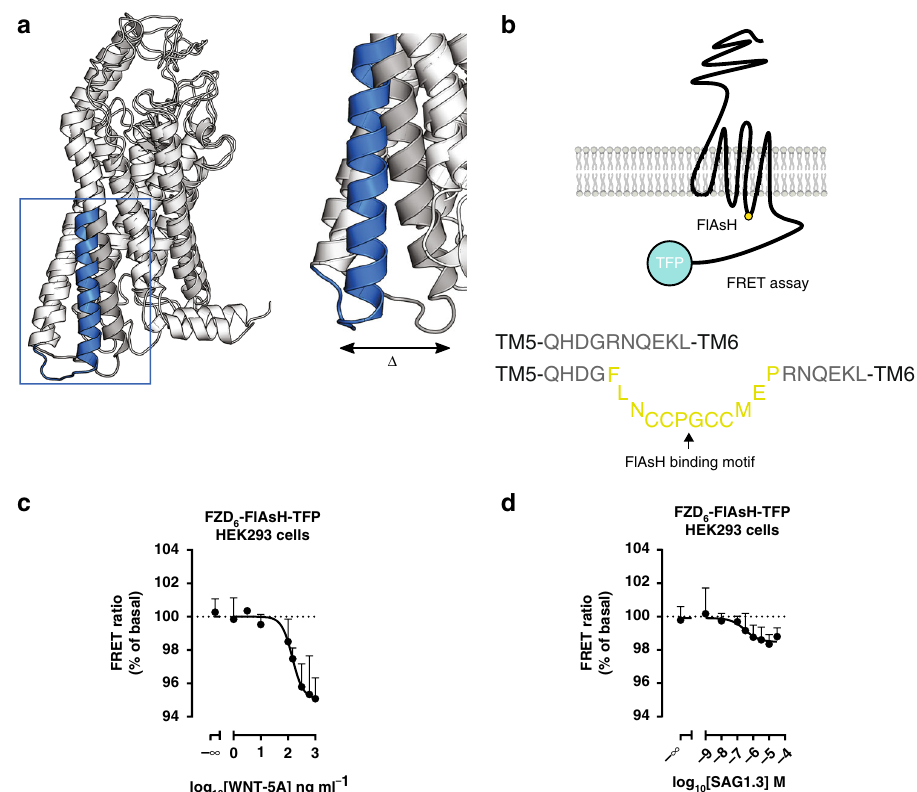
Fig. 3 SAG1.3 induces conformational changes in FZD 6 . a The model of the active-like FZD 6 (blue) showing a pronounced outward-motion ( Δ ) of the TM6 as compared to the inactive model (gray), justifying positioning of FRET acceptor and donor in the ICL3 and C-terminus, respectively. b The scheme depicts the FZD 6 – FlAsH – TFP construct. The FlAsH-binding motif (FLNCCPGCCMEP) was inserted into the ICL3, between G404 and R405. Receptor activation is predicted to result in a loss of FRET due to conformational rearrangement in accordance to previous data obtained for FZD 5 16 . c WNT-5A induced a concentration-dependent decrease of the FRET ratio (FlAsH/TFP) in HEK293 cells overexpressing FZD 6 – FlAsH – TFP. The FRET ratio change induced by each concentration was normalized to basal FRET ratio. Data are represented as mean ± s.e.m. of total n = 5 individual experiments. d SAG1.3 induces a concentration-dependent decrease of the FRET ratio (FlAsH/TFP) in HEK293 cells overexpressing FZD 6 – FlAsH – TFP. The FRET ratio change induced by each concentration was normalized to basal FRET ratio. Data are presented as mean ± s.e.m. of total n = 7 individual experiments. Source data are provided as a Source Data fi